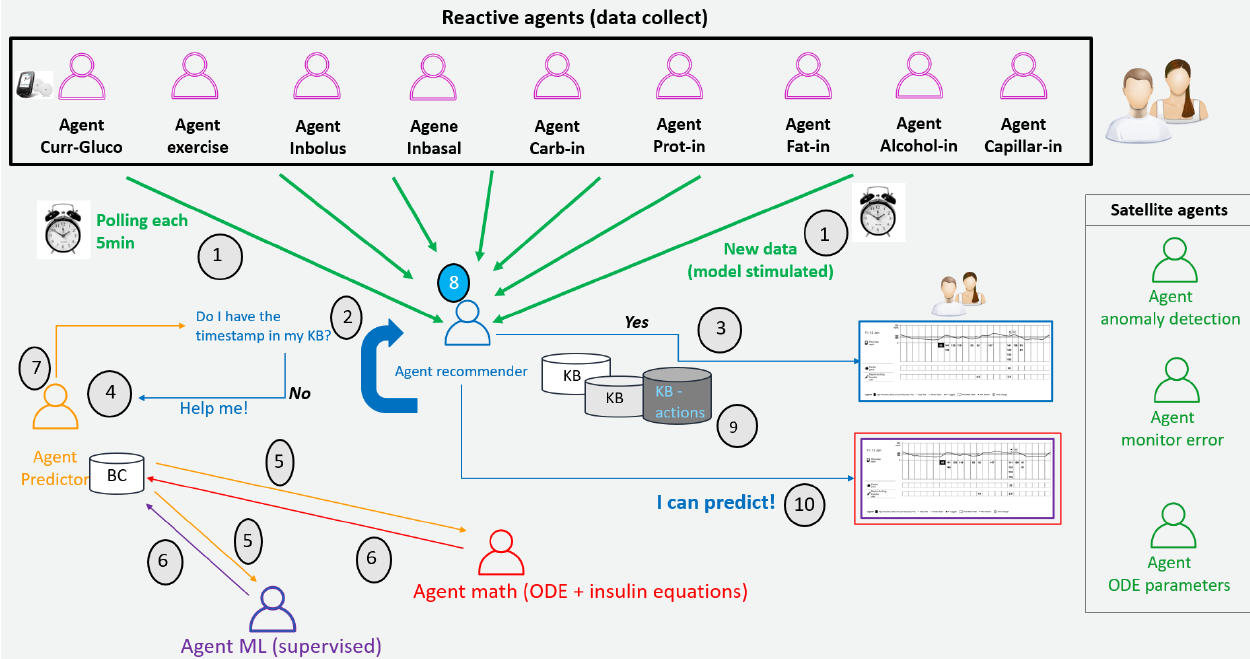
Figure 3. Tesseratus